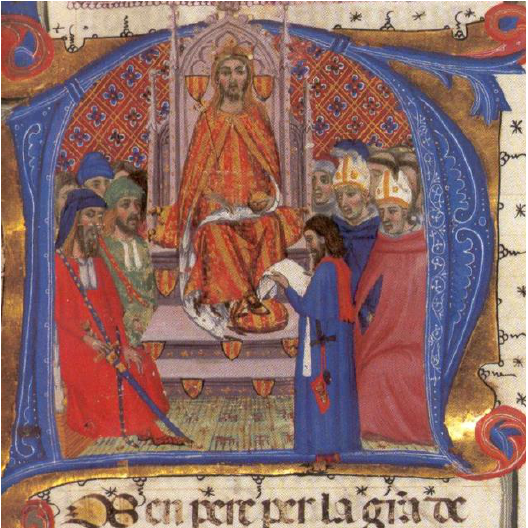
Figure 4. Ordinacions de Cort , Ms. Esp. 99, Paris, Biblothèque Nationale de France © . Fol. 1r.